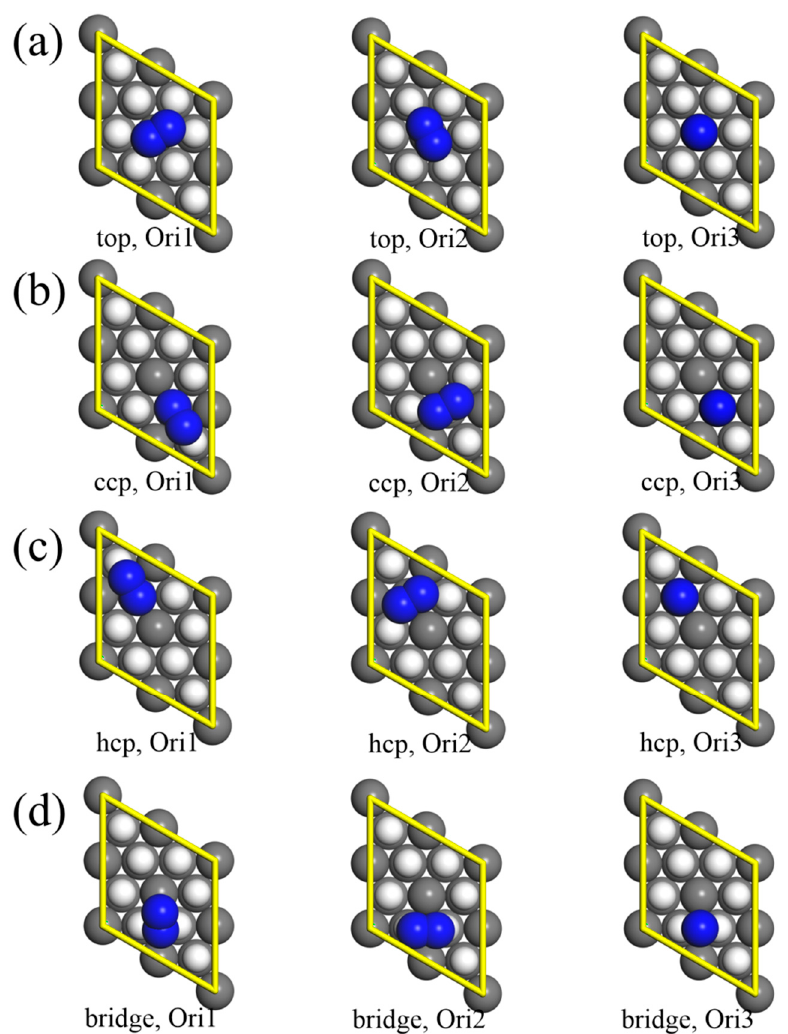
Figure 2. Molecular nitrogen adsorption onto PuH 2 (111) surfaces with different sites and orientations: ( a ) top, ( b ) ccp, ( c ) hcp, and ( d ) bridge site. The gray, blue, and white spheres represent Pu, N, and H atoms, respectively.